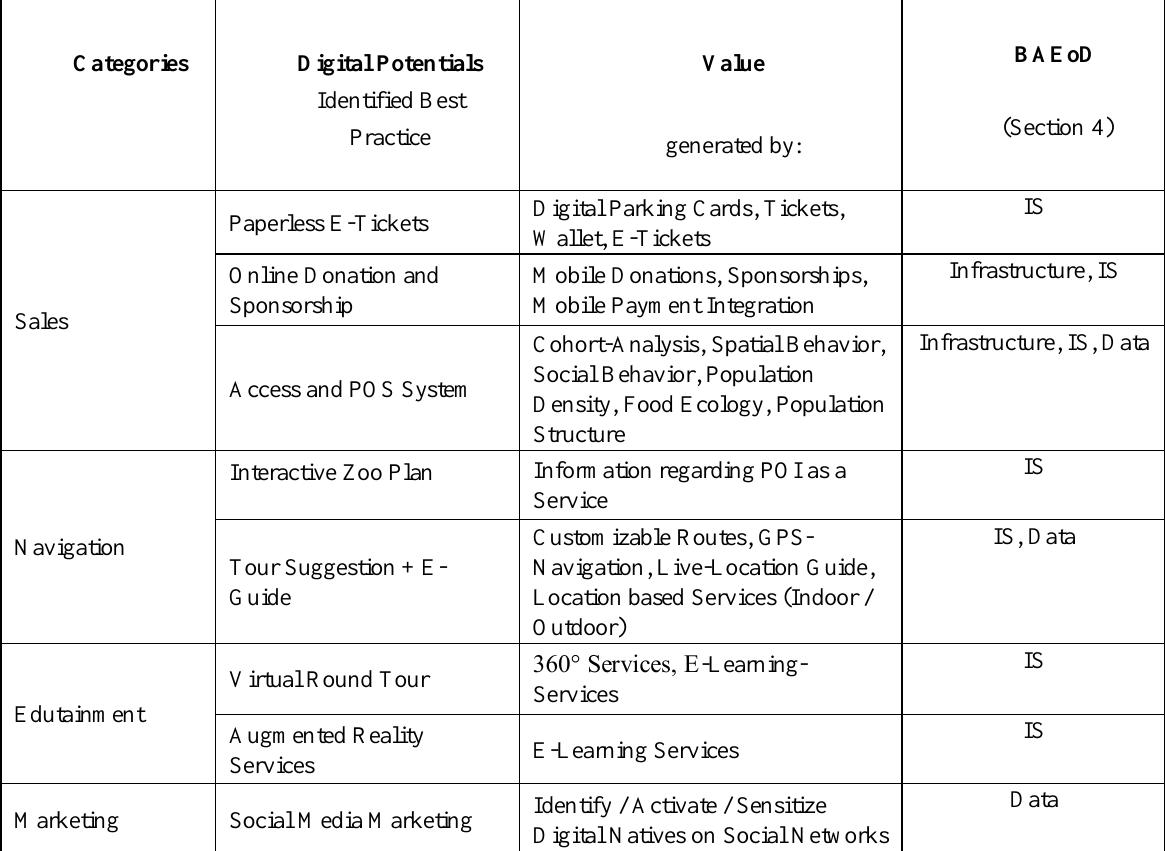
Table 3. Digital Potentials and Value for zoo gardening facilities